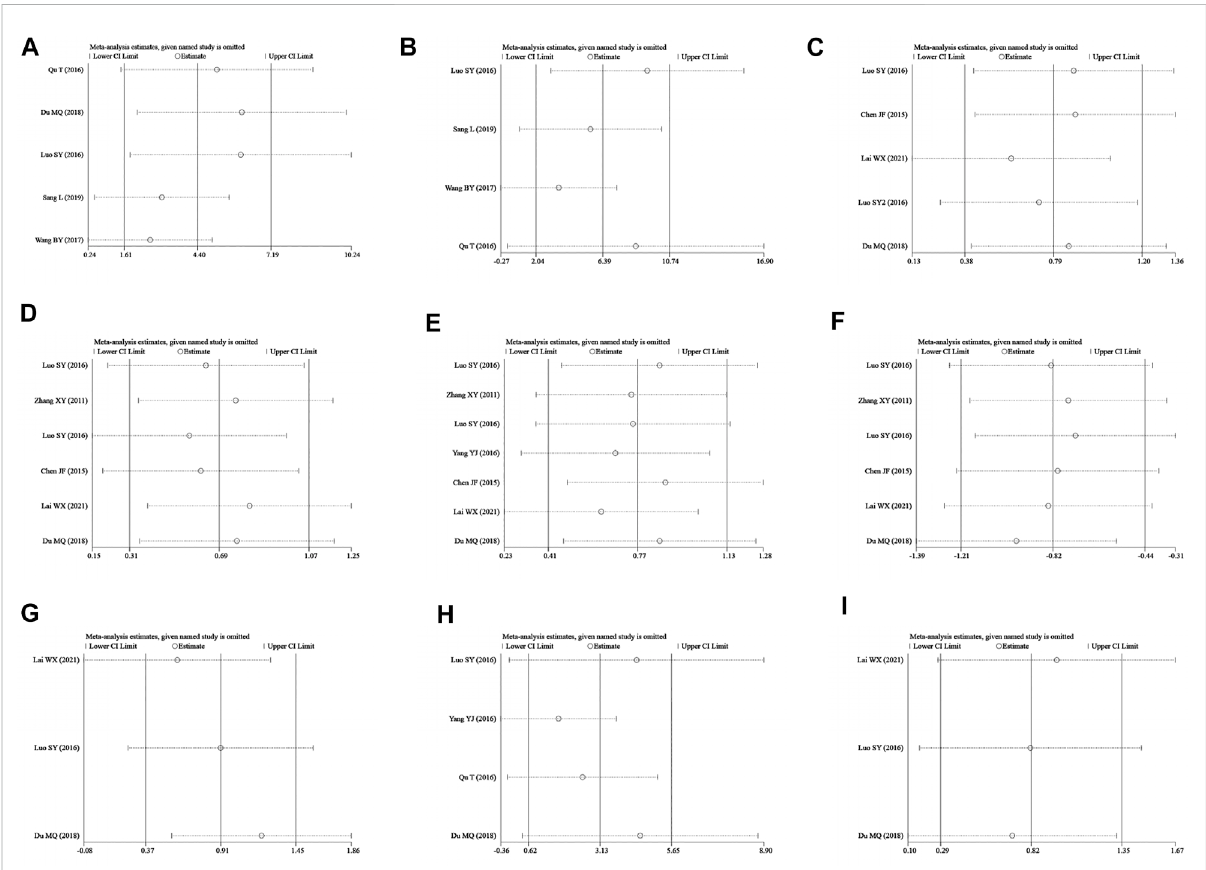
FIGURE 12 Sensitivity analysis. (A – I) represent the sensitivity of BMD-femur, BMD-lumbar, BV/TV, Tb.N, Tb.Th, Tb.Sp, bone max load, S-OCN, and bone elastic, respectively. The sensitivity analysis was conducted by omitting single studies one by one, and no study with critical in fl uence was